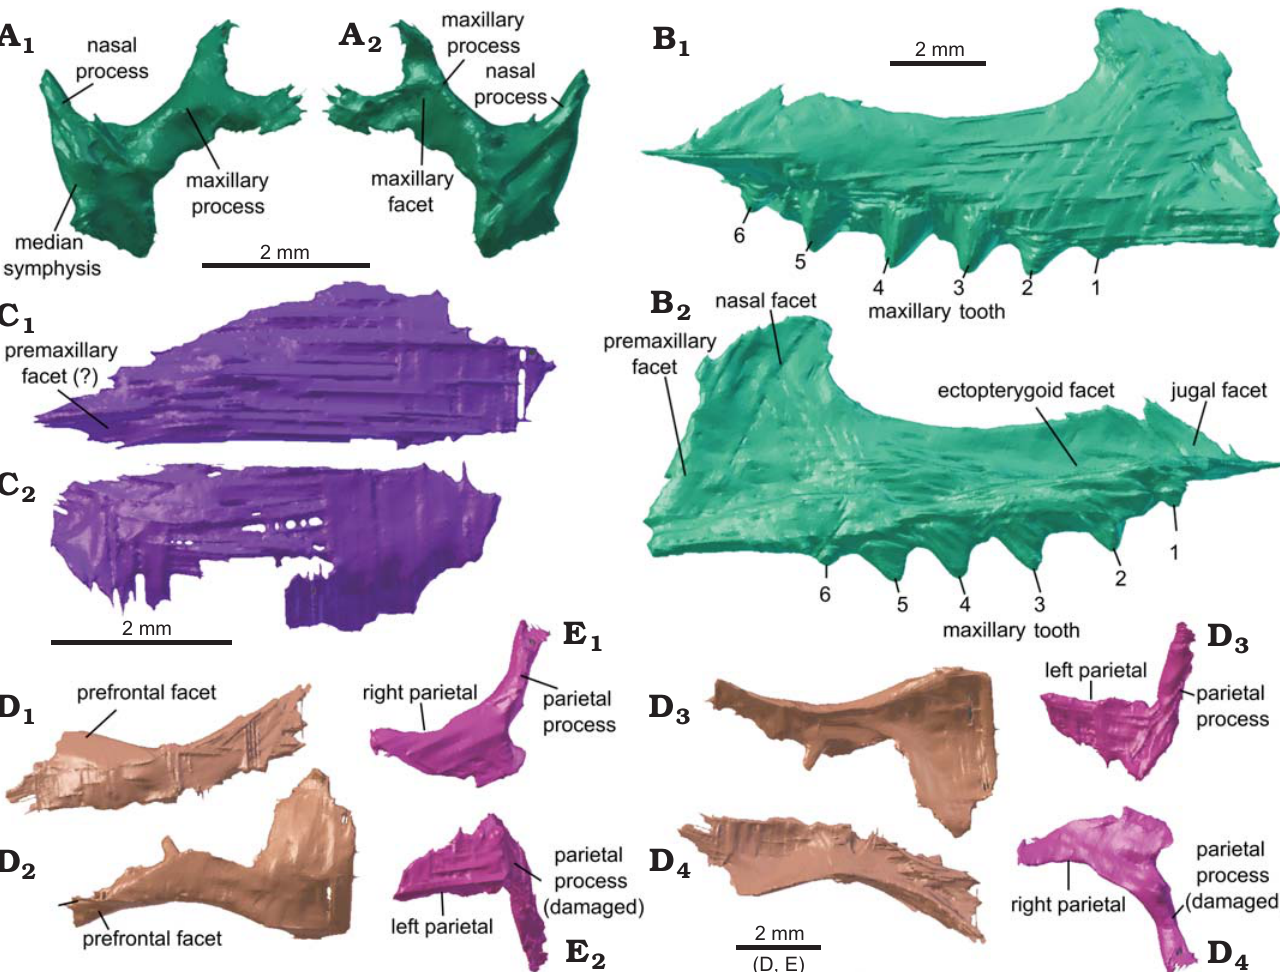
Fig. 6. Cranial bones of lepidosaur rynchocephalian Clevosaurus cambrica Keeble, Whiteside, and Benton, 2018 (NHMUK PV R37014) from Late Triassic, Pant-y-ffynnon, Wales, UK. A . The right premaxilla in medial (A 1 ) and lateral ( A 2 ) views. B . The right maxilla in lateral (B 1 ) and medial (B 2 ) views. C . The right (C 1 ) and left (C 2 ) nasal in dorsal view. D . The right (D 1 , D 4 ) and left (D 2 , D 3 ) frontals in dorsal (D 1 , D 2 ) and ventral (D 3 , D 4 ) views. E . The right (E 1 , E 4 ) and left (E 2 , E 3 ) parietals in dorsal (E 1 , E 2 ) and ventral (E 3 , E 4 )